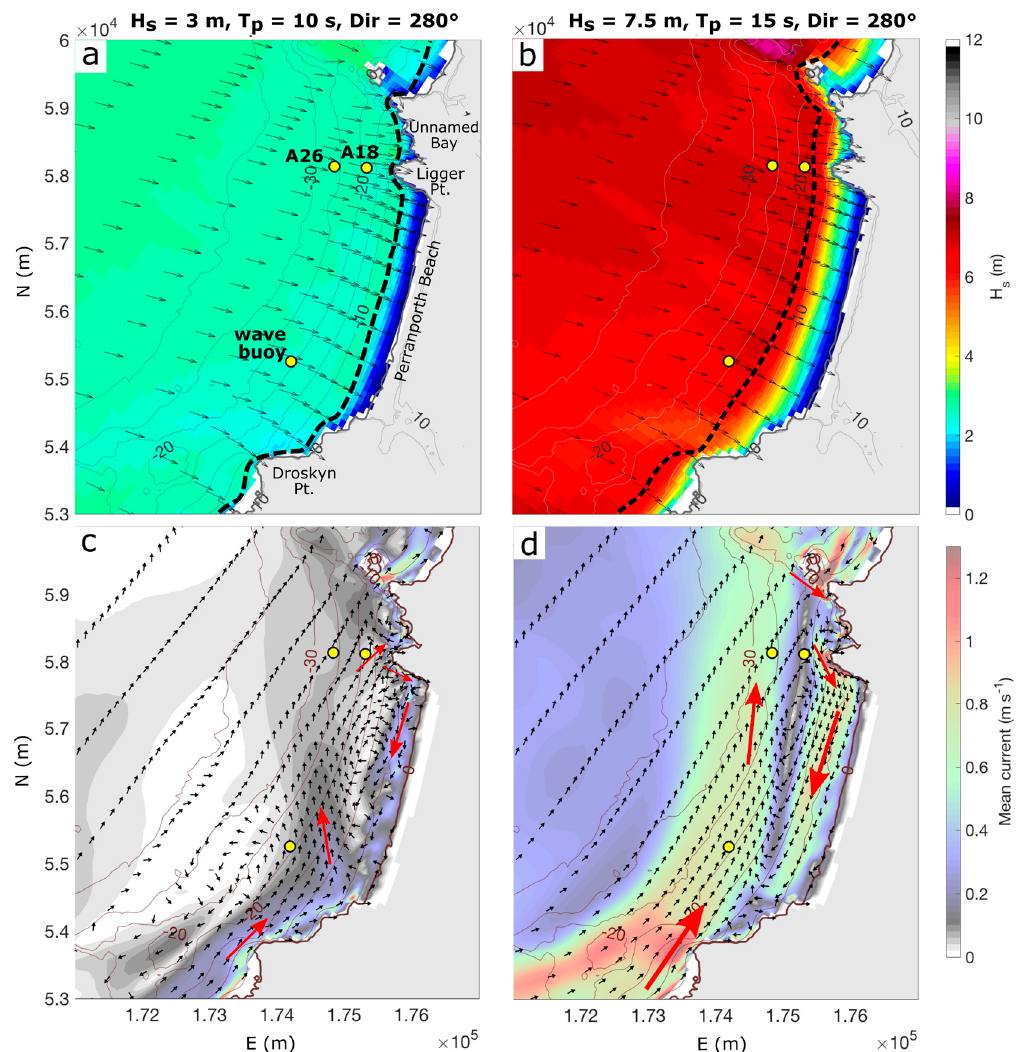
Figure 10. Circulation under moderate–high waves (left column) and extreme waves (right column) averaged over a 25-h period during neap tides. The synoptic plots include the wave height (top-row) and current velocity (bottom row). In all panels, uniformly sized arrows indicate the direction while colour indicates magnitude. The ADCP and wave buoy locations are indicated by yellow circles. The approximate extent of the surf zone is indicated by black dashed lines in ( a , b ).